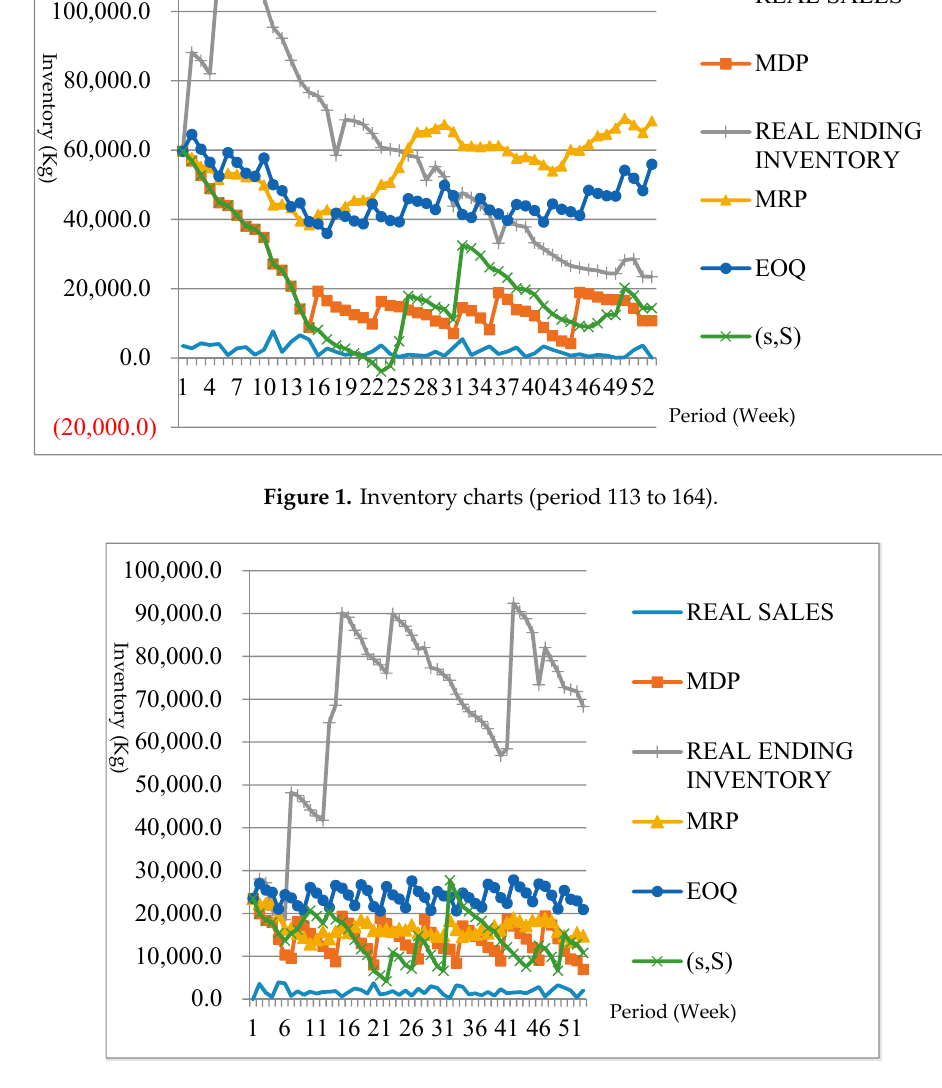
Figure 3. Inventory charts (period 165 to 216, excluding actual ending inventory).